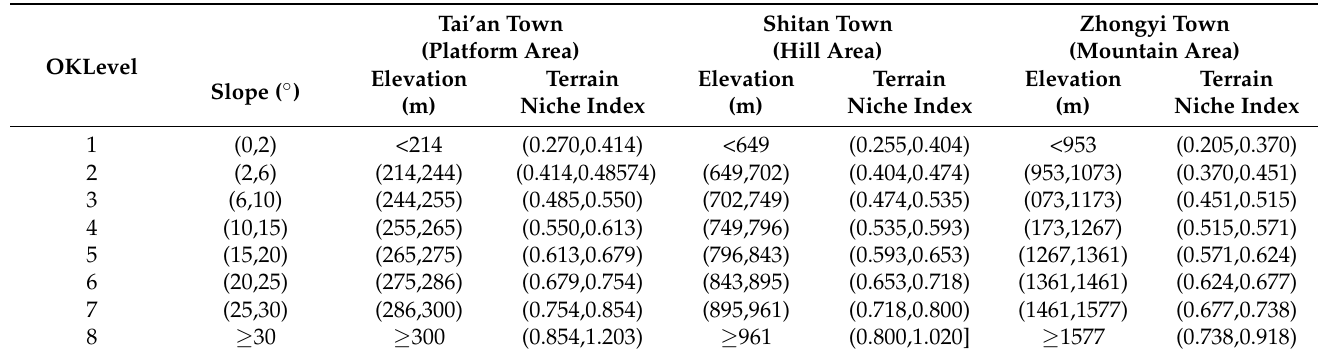
Table 3. Elevation, slope, and terrain niche index in different landform